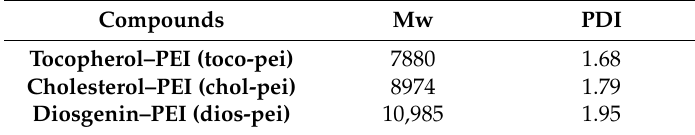
Table 1. Molecular weights (Mw) and polydispersities (PDI) of lipopolymers.